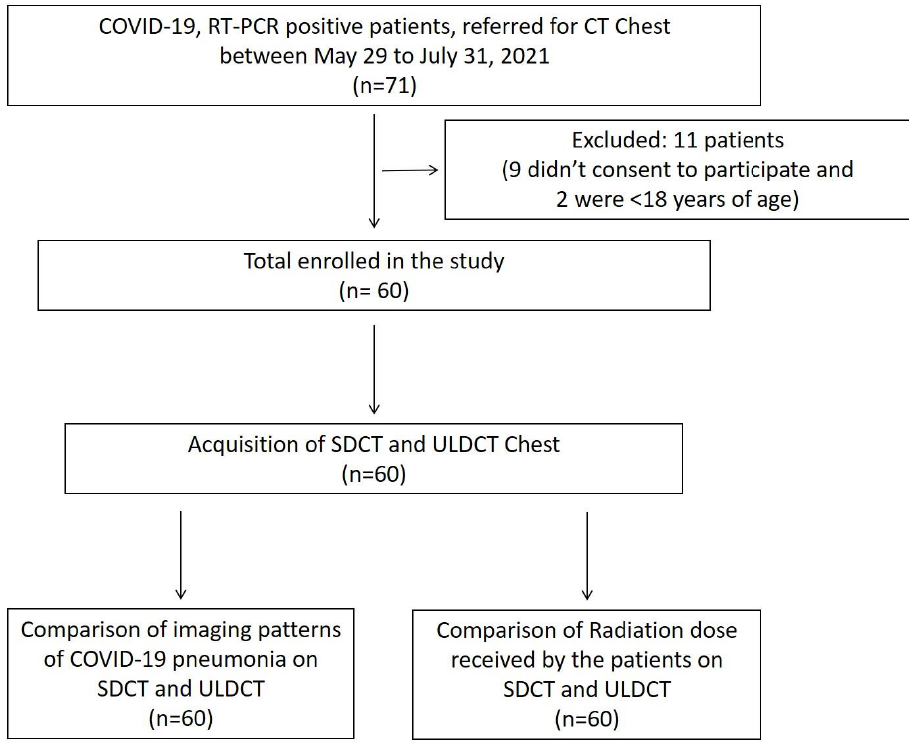
Figure 1. Flow chart depicting the inclusion process and study design.